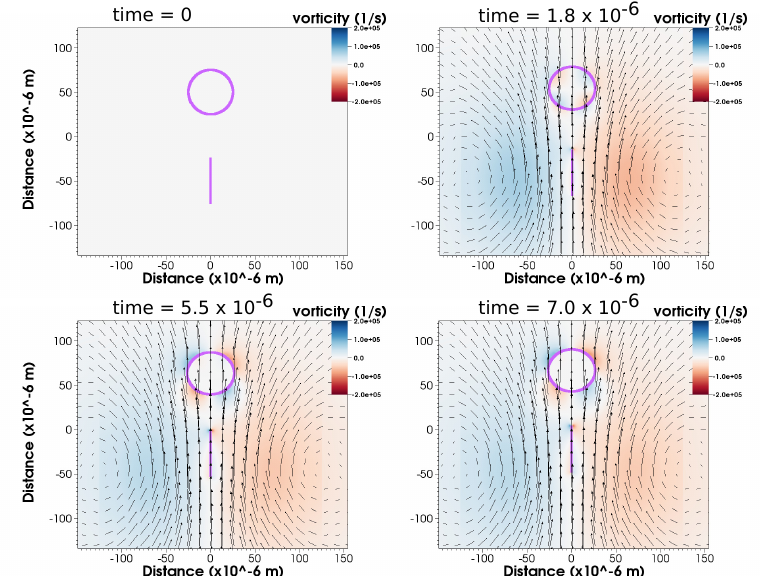
Figure 7. Temporal snapshots showing the vorticity and velocity vector field for Re = 0.9 at the base length and radius. The position of the barb and prey are denoted by magenta, the color map represents the vorticity, and the arrows indicate the fluid velocity. Note that the prey is untethered and moves with the